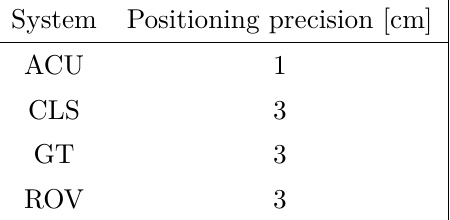
Table 4 . Summary of expected positioning precision for each